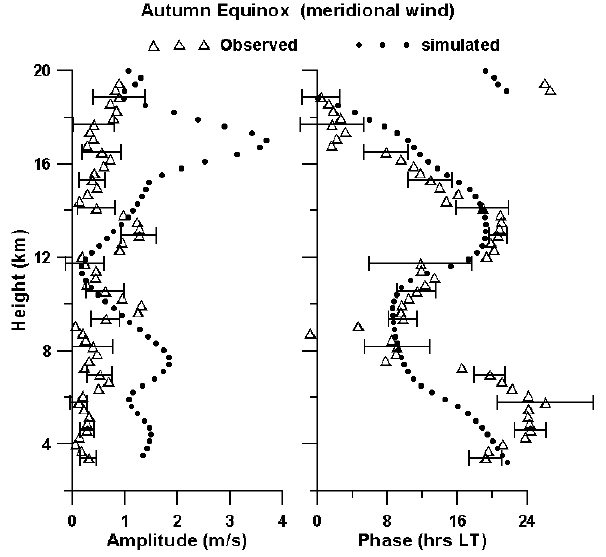
Fig. 2. Vertical profiles of amplitude (left panel) and phase (right panel) of diurnal tides in meridional winds observed over Gadanki (open triangles) during the autumn equinox season. Amplitudes and phases simulated by classical tidal theory for the location of Gadanki (same simulation for all seasons) are also shown (filled cir- cles). The rms errors in amplitudes and phases at ∼ 1 km intervals are shown by horizontal bars.